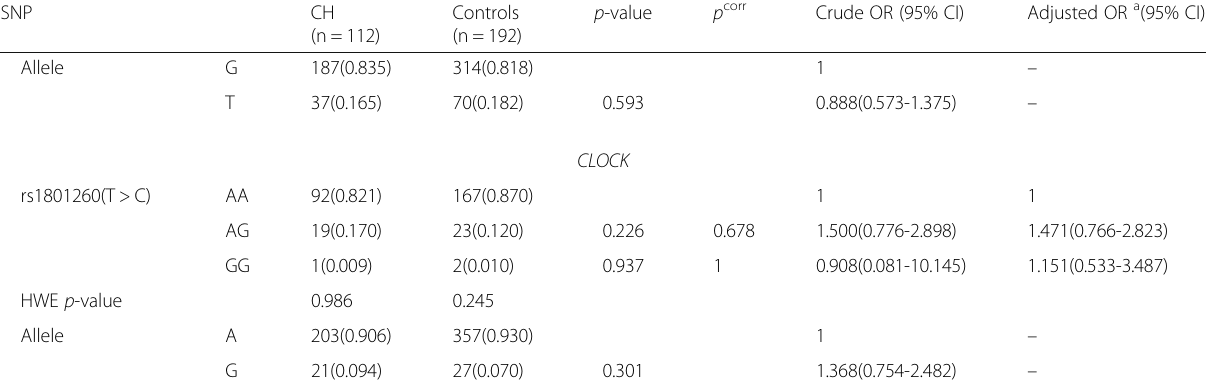
Table 2 Genotype and allele frequency of the polymorphisms between cases and controls (Continued)